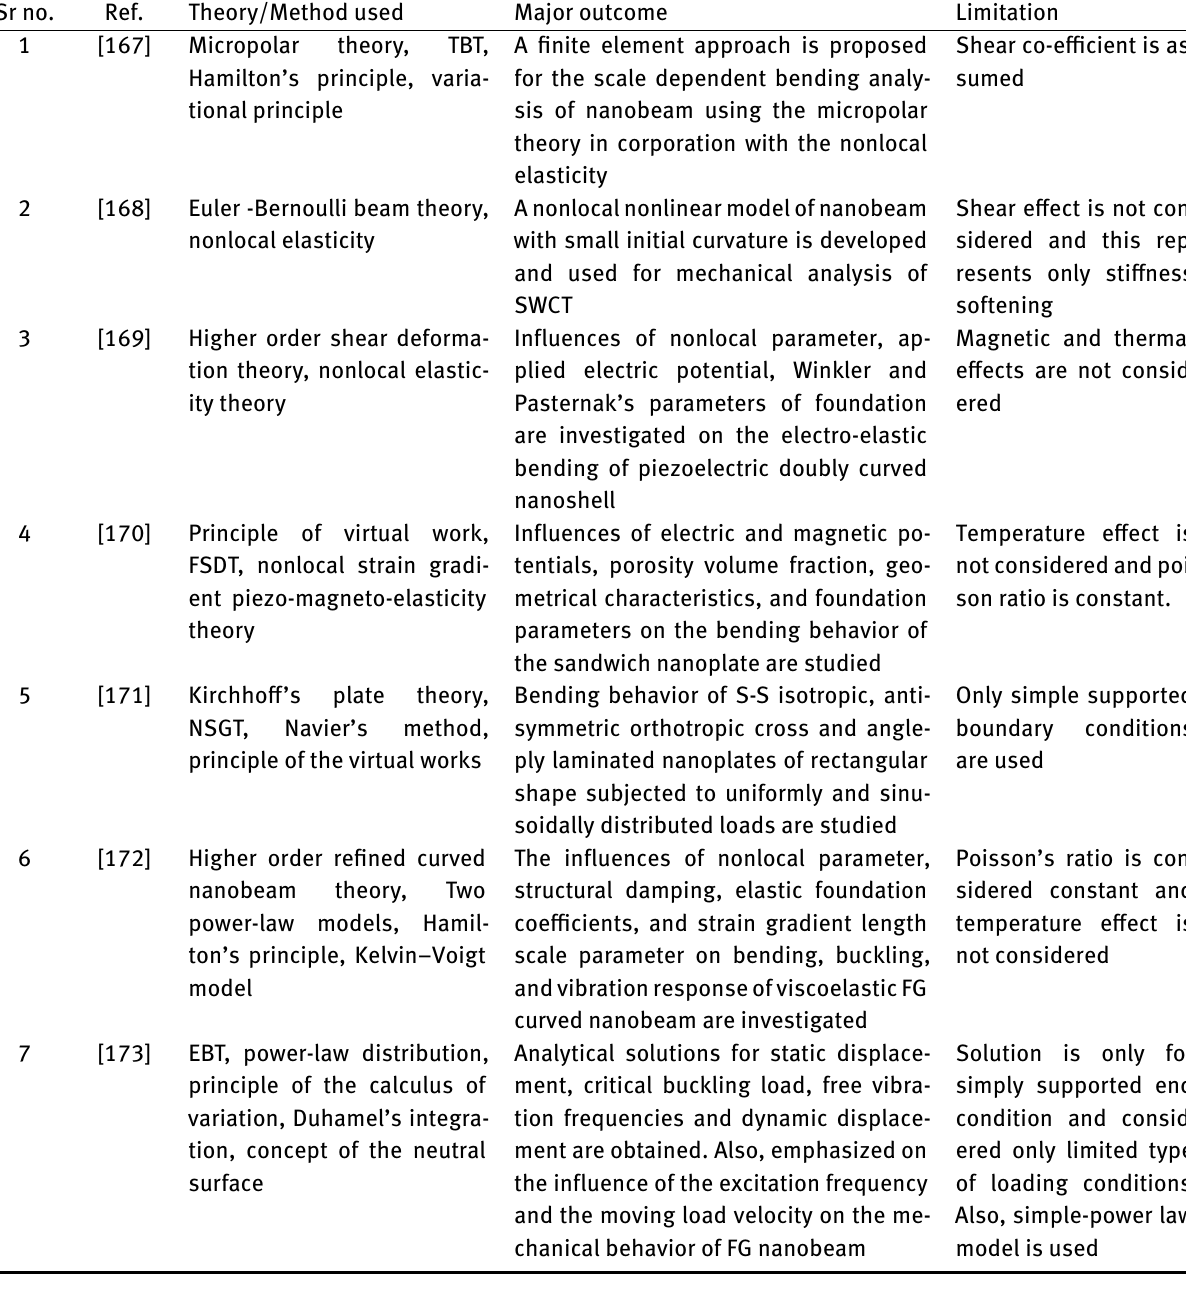
Table 2: Representation of published articles on the bending analysis of nanobeams/nano plates/nanoshells Sr no.